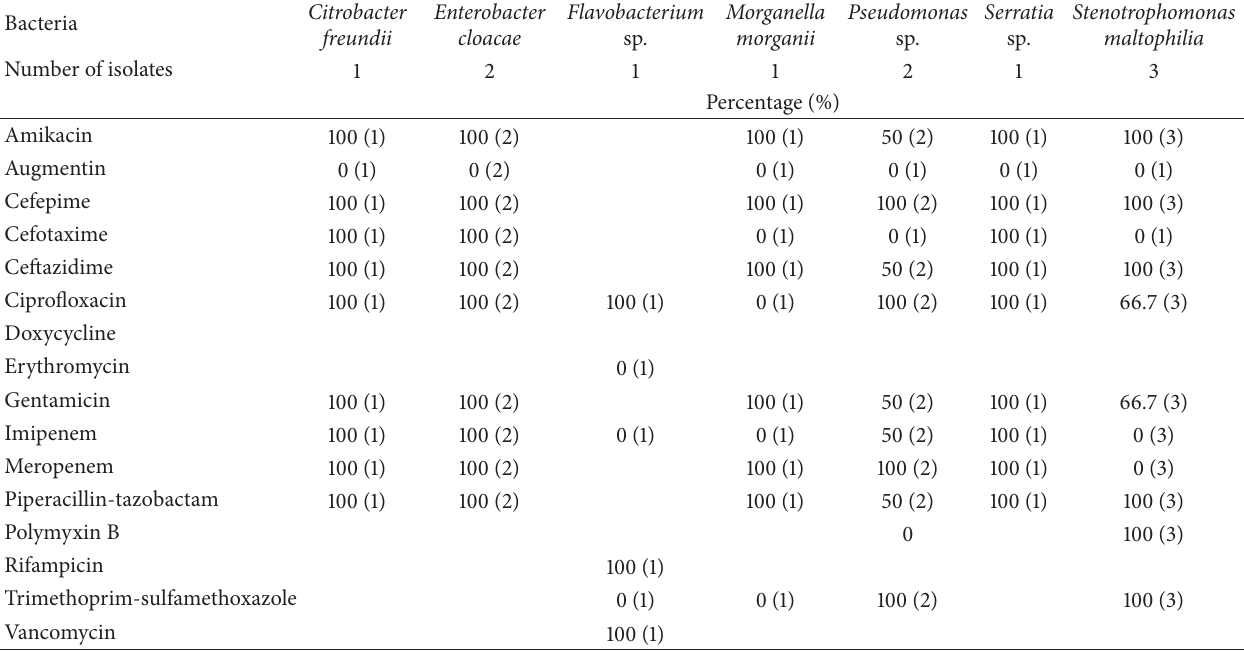
Table 4: Antibiogram for gram-negative